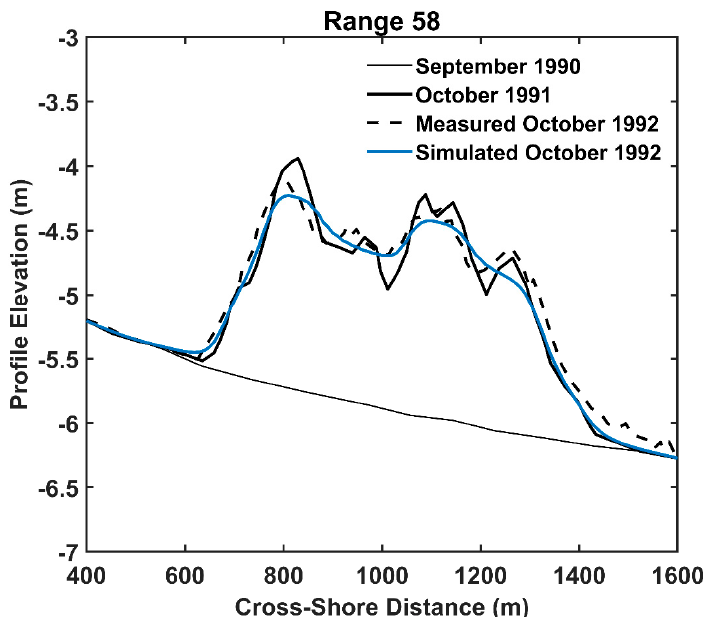
Figure 8. Calculated and measured profiles one year after mound disposal for Range 58.